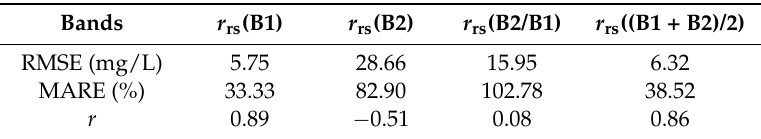
Table 1 . Validation results from the LOOCV results for the SASM for MODIS-Aqua band 1, band 2 and their combinations.